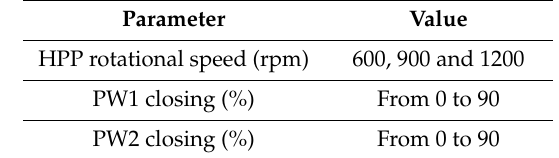
Table 3. Test conditions to select the operating point.